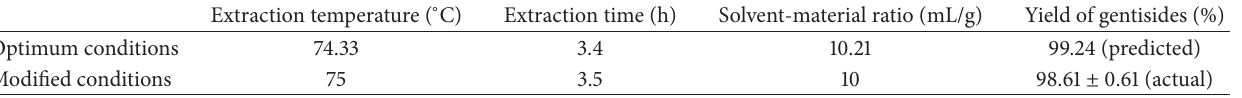
Table 3: Optimum conditions and predicted and experimental values of the responses at actual extraction